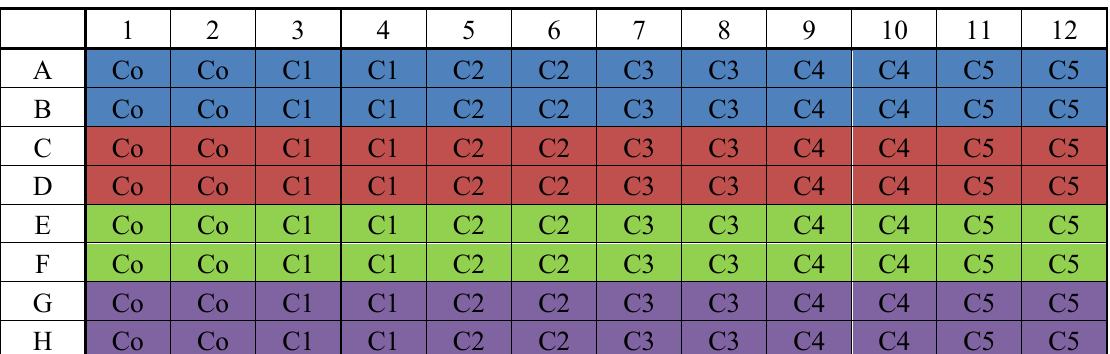
Table 1. Experimental design on the microplate Co: control (no herbicide), C1 = 0.001